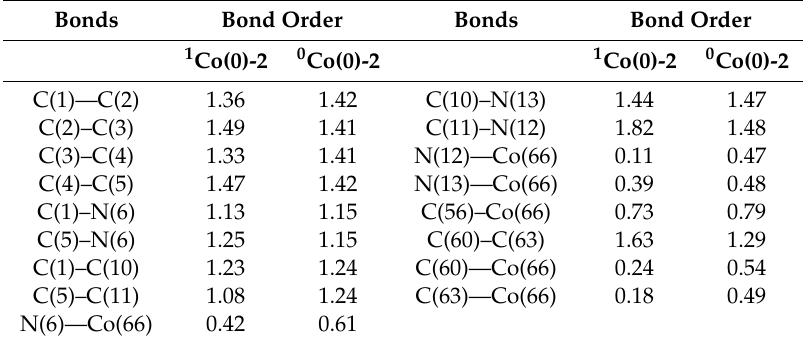
Table 1. Bond order of the bonds in the active center for 1 Co(0)-2 and 0 Co(0)-2 by Mayer bond order analysis (“—” represents coordination interaction and “–” represents a chemical bond).